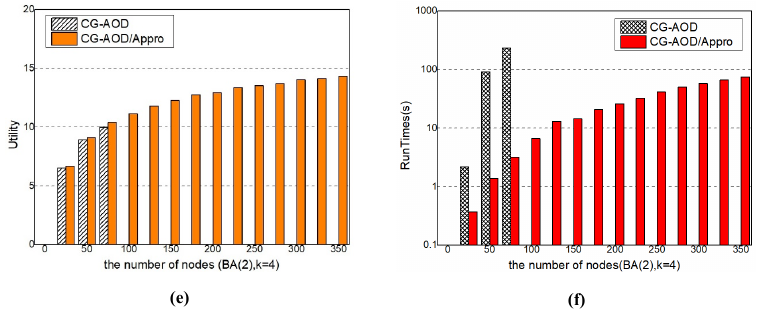
Figure 6. The Utility ( a ) and Runtime ( b – d ) of CG-AOD and CG-AOD / Appro ( e , f